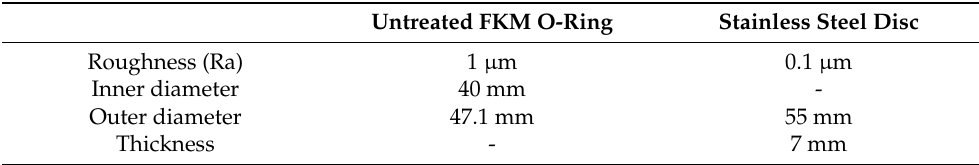
Table 1. Dimensions of FKM rubber seals and stainless steel disc.